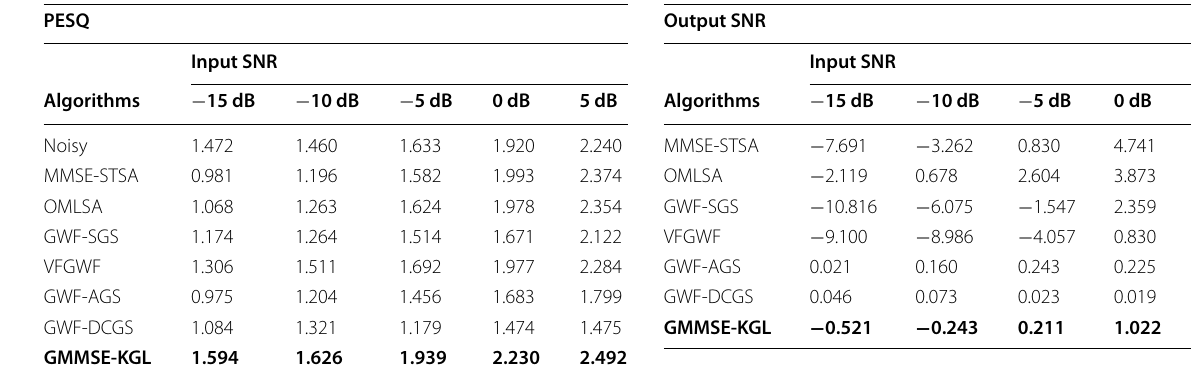
Table 13 The output SNR of different methods for Babble